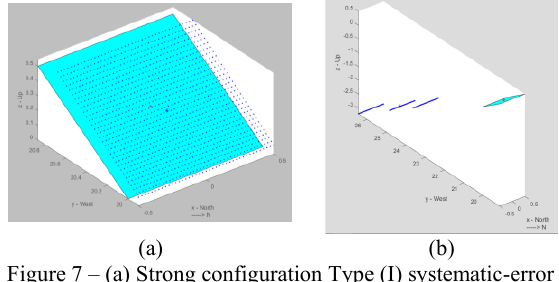
Figure 7 – (a) Strong configuration Type (I) systematic-error visibility criterion (b) Weak configuration Type (I)